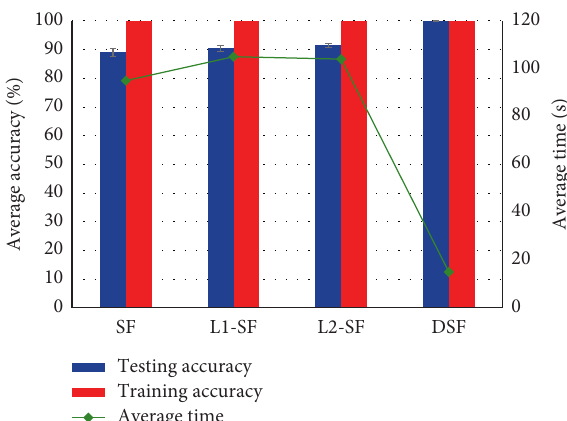
Figure 8: Comparison of the average diagnostic accuracies of four SF